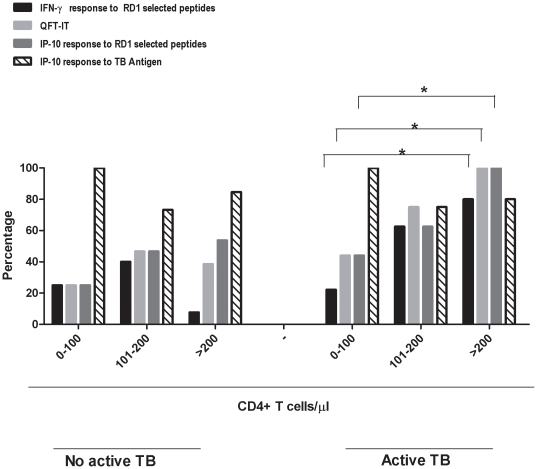
Percentage of positive response to IFN-γ and IP-10-based tests in response to RD1 selected peptides and QFT-antigen in HIV-infected individuals stratified in 3 CD4+ T-cells categories: i) between 0–100/µl, ii) 101–200/µl, and iii) above 200/µl.P values are reported, *: p<0.05. Among those with active TB, there was a significant difference by χ2 for the trend between the categories of the CD4+ T-cell counts and the proportion of responders to the IFN-γ-based experimental test (p = 0.032), IP-10-based experimental test (p = 0.048) and for the IFN-γ-response to the TB antigen of the QFT-IT.